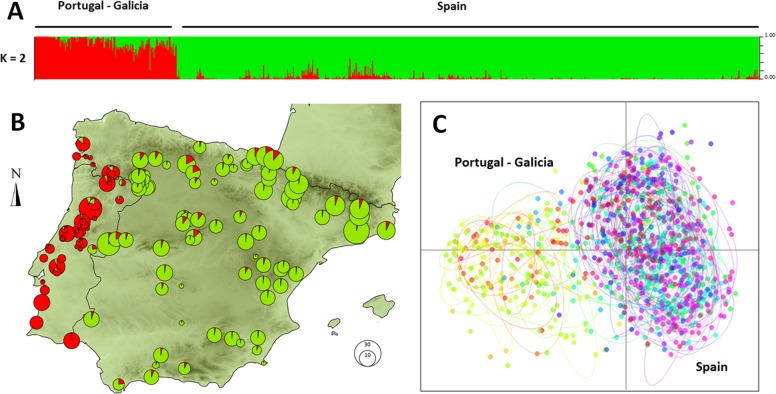
Genetic clustering of 992 individuals of Monochamus galloprovincialis sampled at 132 locations.(A) Assignment of individuals to clusters based on a STRUCTURE analysis for K = 2. (B) Assignment of demes to clusters for k = 2, displayed in geographic context (Iberian Peninsula, the size of the pies refers to the size of the demes). (C) PCA of individuals on first and second axes, colors and ellipses refer to demes.